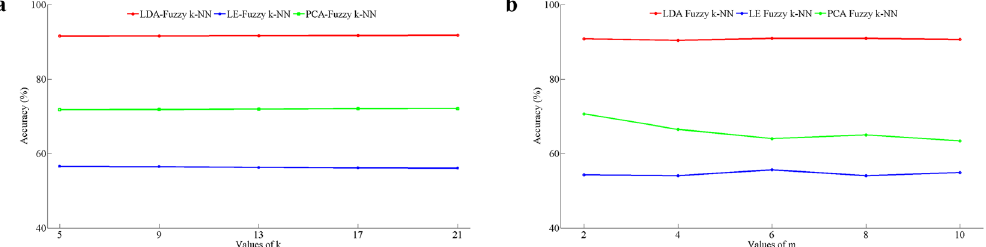
Figure 5. Optimization of Fuzzy k-NN algorithm parameters ( k, m ).